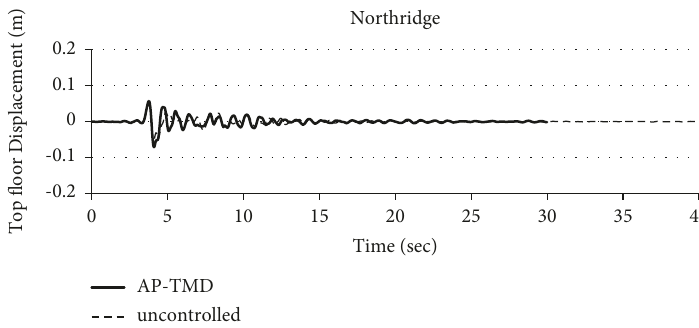
Figure 18: Top floor displacement of structure under Northridge.